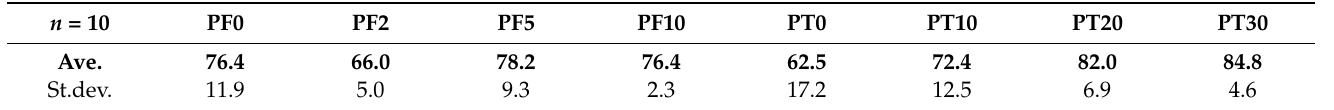
Table 5. Variation of the Shore hardness on resin flooring samples with increasing DCAP content for the PF (left) and PT (right) samples.